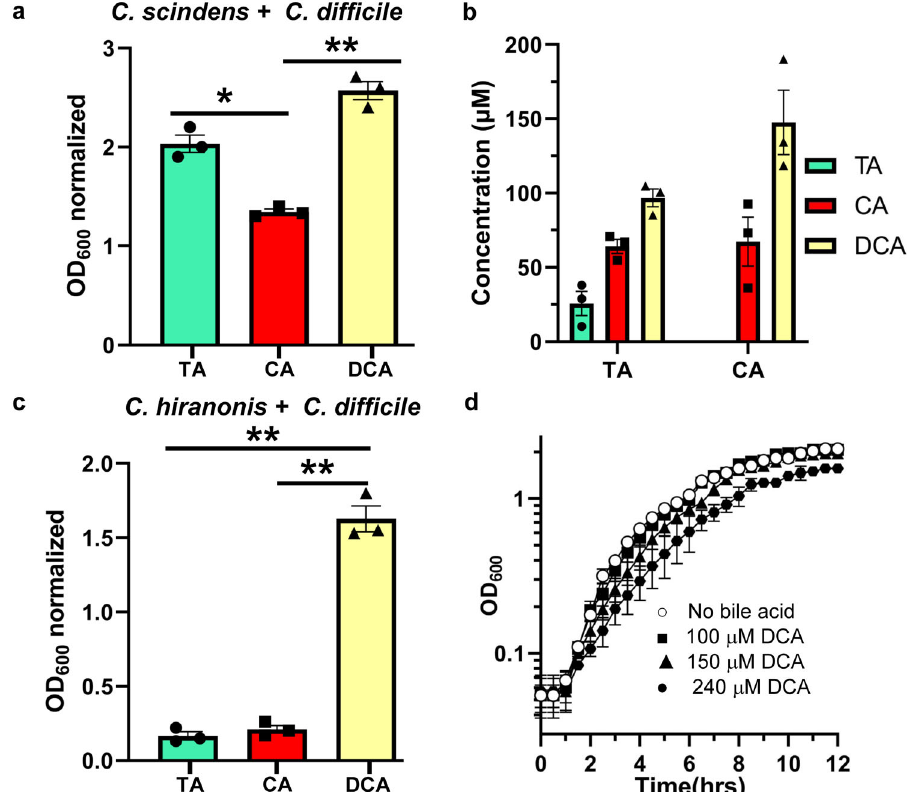
Fig. 7 C. dif fi cile BSH activity contributes to bio fi lm formation in a C. dif fi cile - C. scindens dual-species bio fi lm. a C. dif fi cile was co-cultured with C. scindens with speci fi c bile salt concentrations (TA, CA, DCA), and the amount of bio fi lm formation was quanti fi ed using a crystal violet assay. Values shown are the average of three different independent experiments, and error bars represent the standard error of the mean. The values shown have the negative control conditions (growth without bile acid) subtracted to re fl ect the amount made in response to the indicated condition. b Measured concentrations of the indicated bile salts (TA, CA, DCA) in the C. dif fi cile – C. scindens bio fi lm assay wells. Unwashed bio fi lms were used to measure bile salt concentrations in wells due to loss of supernatant when washing with PBS for crystal